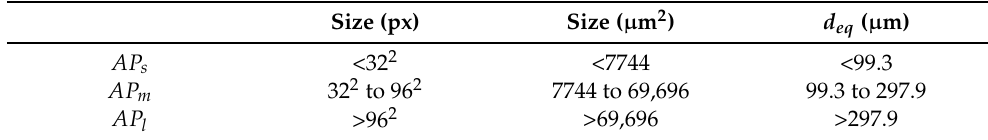
Table 1. Size categories of COCO-AP-metric and corresponding actual